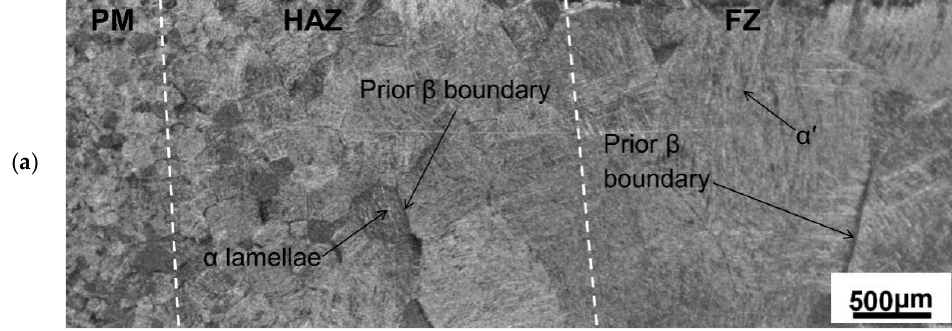
Figure 11. Microstructure of base alloy showing equiaxed α grains in prior β matrix.